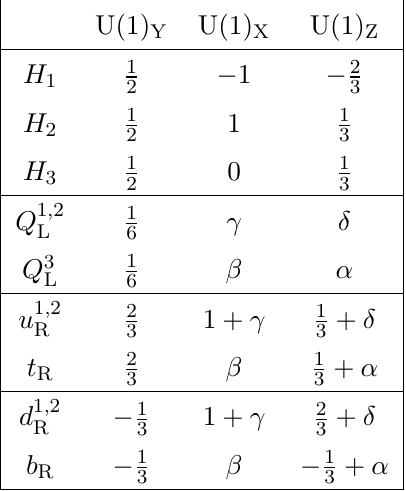
Table 1 . Gharges of the global U(1) X , U(1) Z and gauge (hypercharge) U(1) Y symmetries in the considering class of 3HDMs. The fermion charges together with the constraints in eq. (2.9) are chosen so that the only allowed Yukawa terms are those in eq.